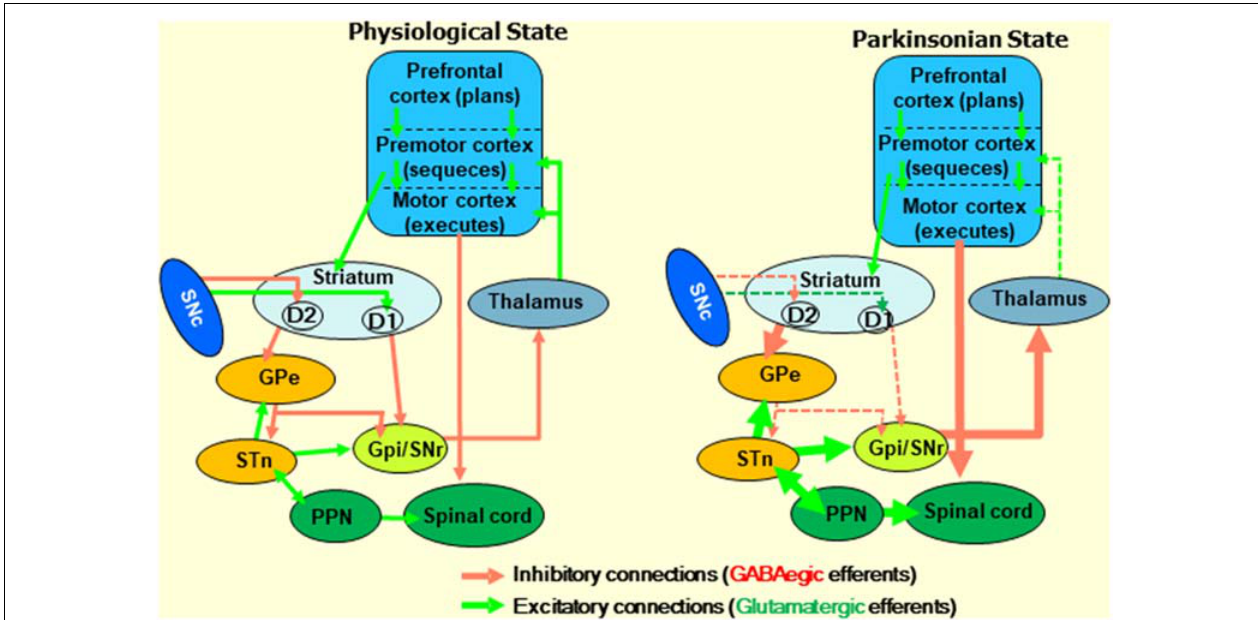
FIGURE 2 | Diagram describing the frontostriatal motor loop controlling motor function under physiological and parkinsonian states. The prefrontal cortex (PFC) participates in cognitive control and planning of movements. The premotor cortex organizes sequences of body actions, and the primary motor cortex is responsible for executing them. Excitatory signals, which are initiated by cortical glutamatergic neurons, project from the PFC to the premotor cortex, and then to the motor cortex through several subcortical structures. Then, the resultant signals received by the pyramidal cells of the motor cortex go to the motor neurons of the spinal cord. Together, this is called the frontostriatal motor loop. Midbrain dopaminergic neurons play an essential role in modulating the signals that go along the frontostriatal motor loop. Changes in the direct inhibitory (initiated by D2 receptors) and indirect (D1 receptors) pathways under parkinsonian states due to the loss of dopaminergic neurons in the SNc are indicated. GABA, γ -aminobutyric acid; SNc, substantia nigra pars compacta; GPe, globus pallidus external; GPi, globus pallidus internal; STN, subthalamic nucleus; PPN, peripeduncular